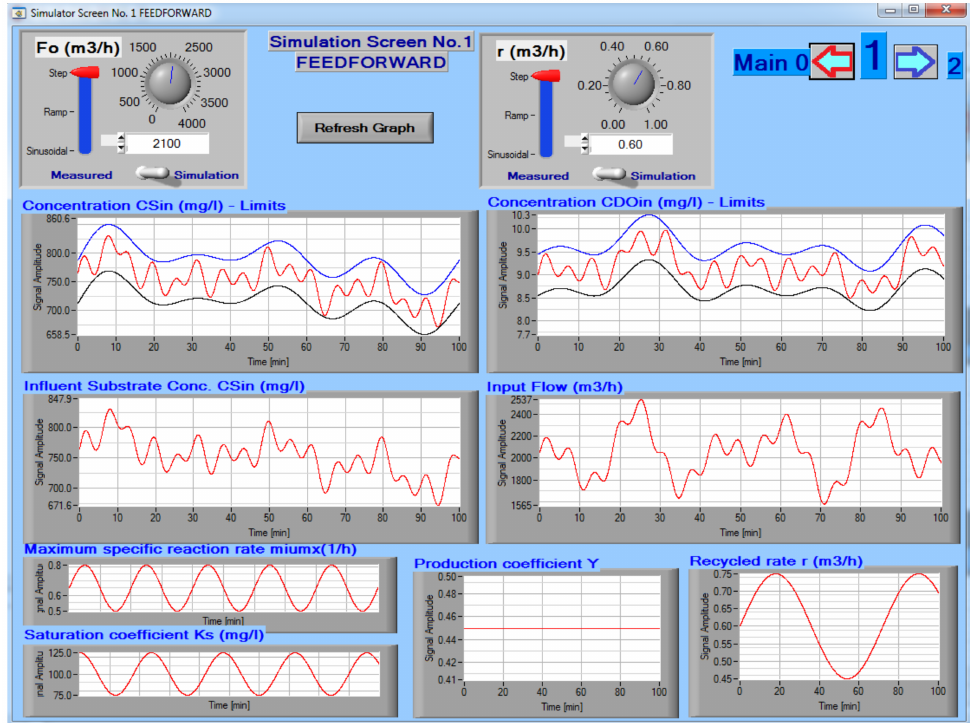
Figure 6. Open-loop simulation of the ASP, the biological treatment stage, with the visualization of the evolution of the main biological variables (the first screen).